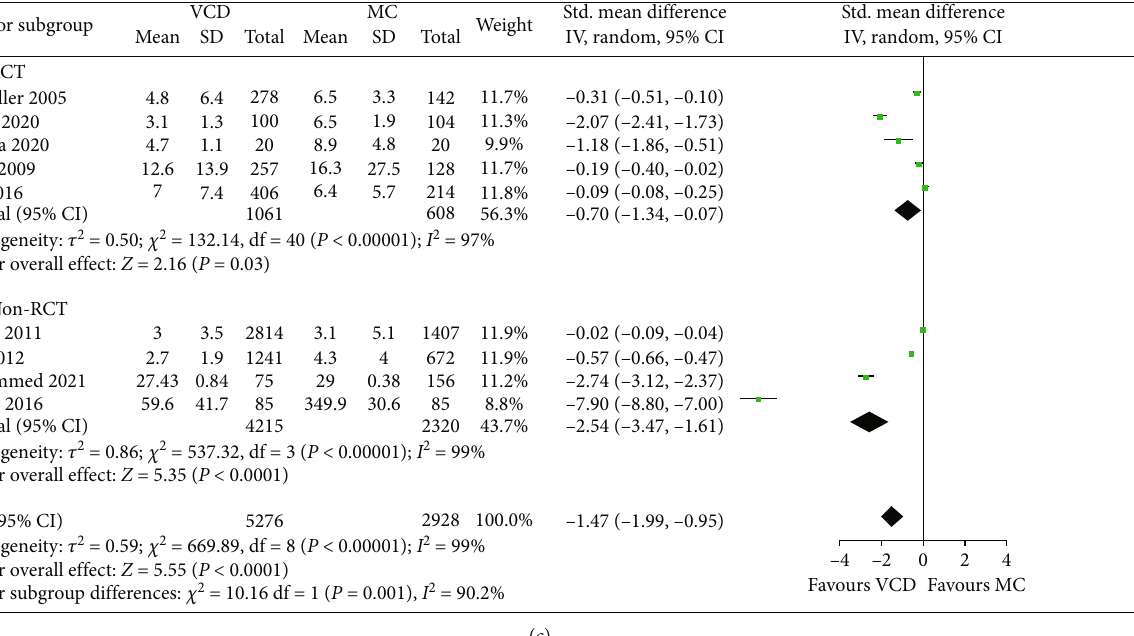
Figure 3: Forest plots comparing (a) TTH, (b) TTA, and (c) TTD between the VCD group and MC